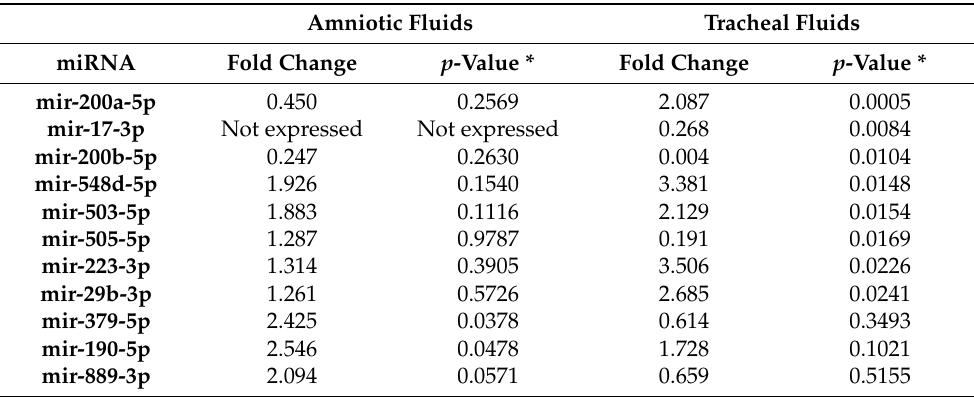
Table 3. Mean concentrations of EV-miRNA levels in survivors and non-survivors measured by OpenArray (miRNA selected for validation